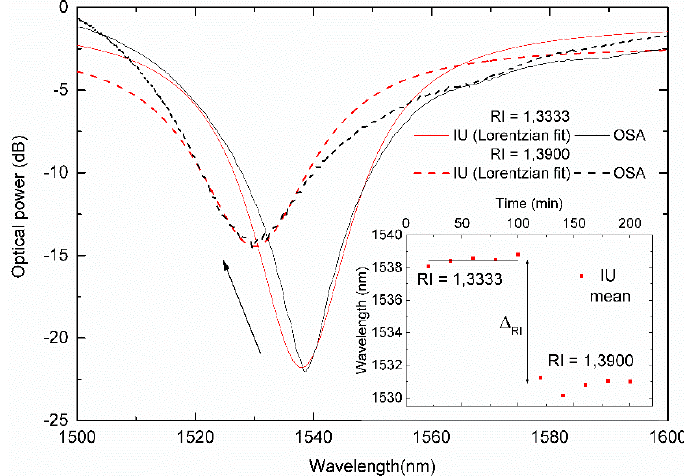
Figure 12. Comparison between the interrogation unit (IU) with a Lorentzian curve fit and the OSA spectra for two refractive index values. The step response is presented in the inset.